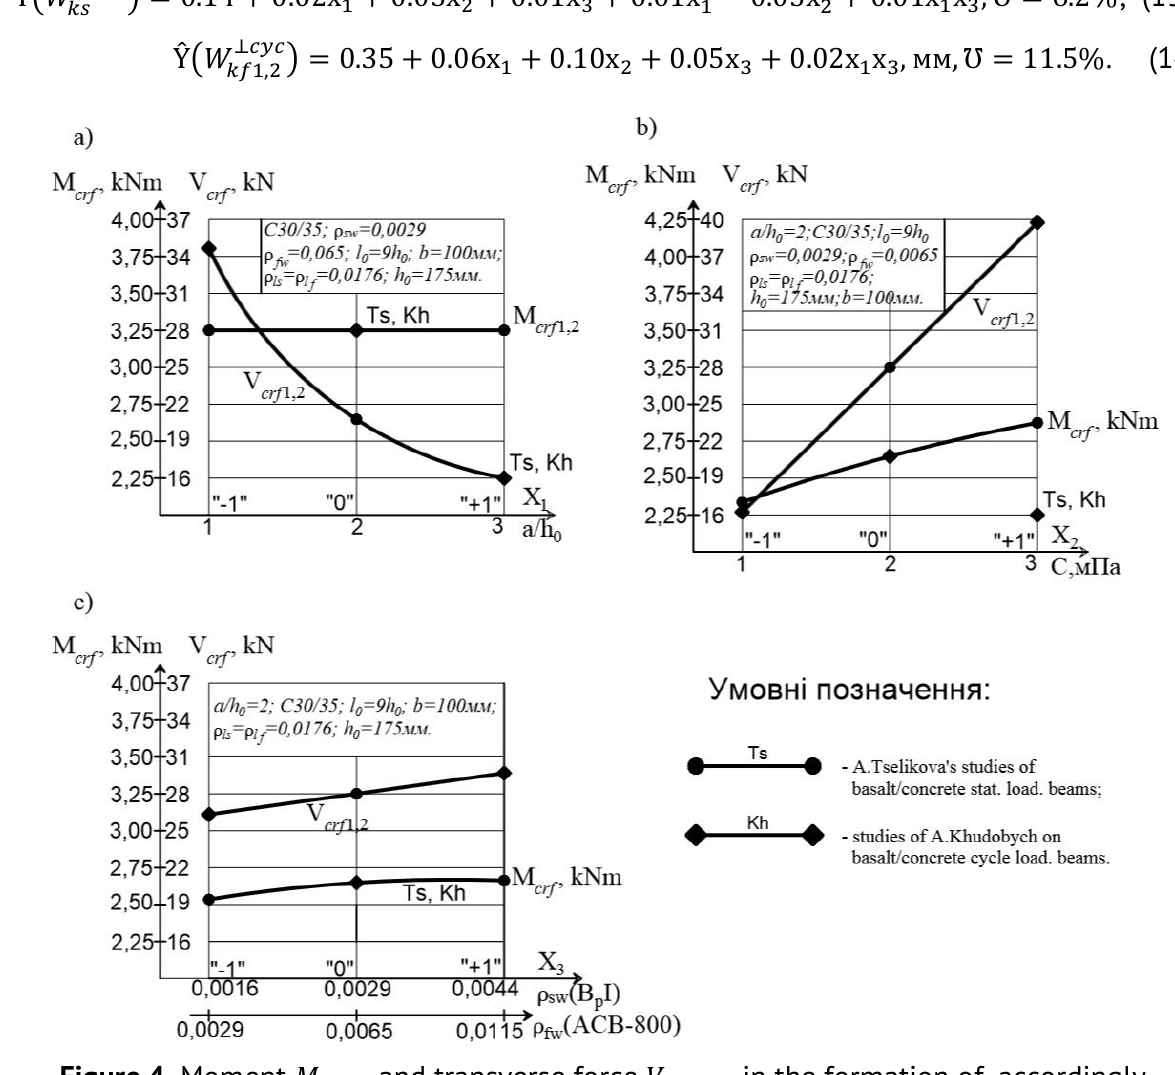
Figure 4. Moment and transverse force in the formation of, accordingly, normal and inclined cracks in the studied BFRP concrete beam samples versus the shear span (а), concrete grade (b) and quantity of the transverse reinforcement (c) subjected to static (index 1) and low-cycle (index 2) repeated